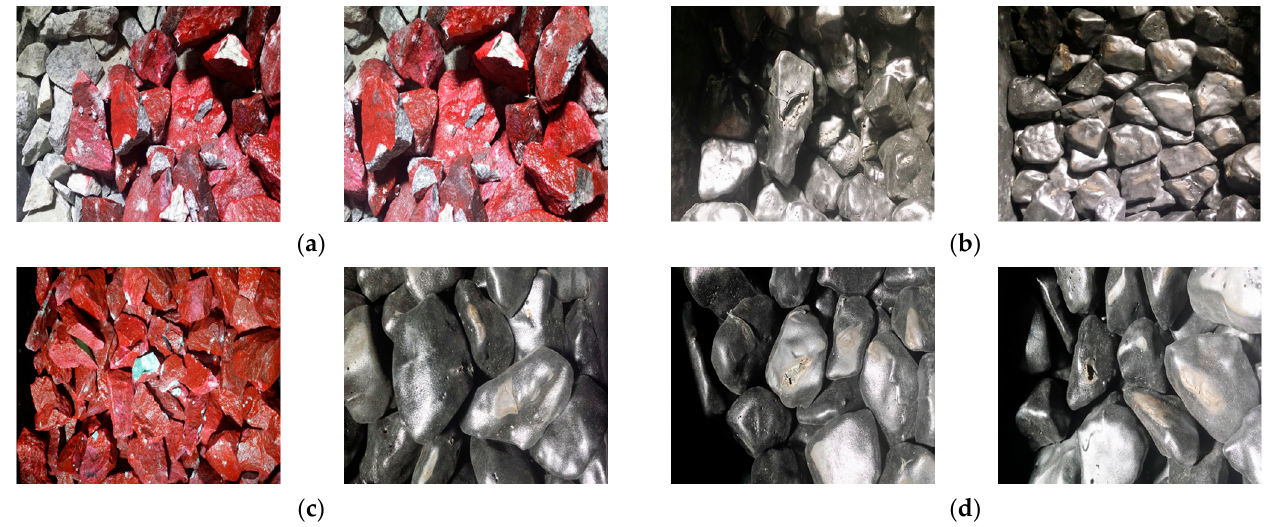
Figure 5. Ballast before and after laboratory experiments: ( a ) normal ballast (300 mm), ( b ) coated ballast (250 mm), ( c ) normal ballast (150 mm) and coated ballast (150 mm), ( d ) coated ballast (100 mm).